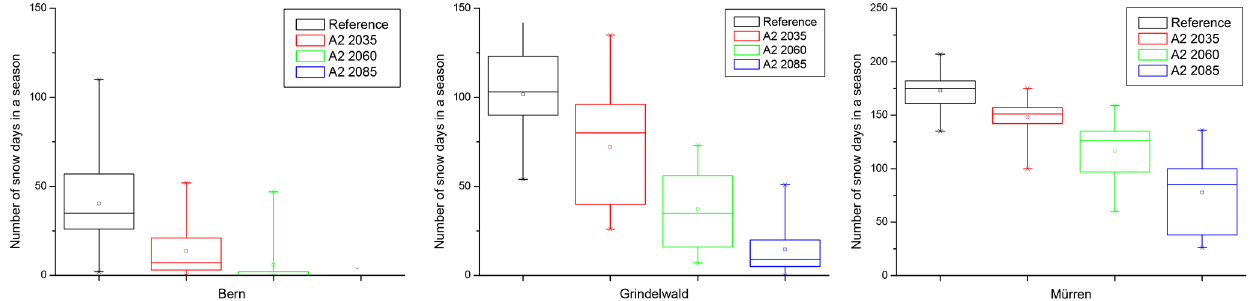
Figure 8. Interannual variability of the number of snow days (snow depth at least 5cm) at three stations (Bern 540m, left; Grindelwald 1030m, center; and Mürren 1650m, right) in the Aare region. The little square in the box plots represents the mean value and the whiskers show the 2.5 and 97.5% quantile value of the different model simulations.